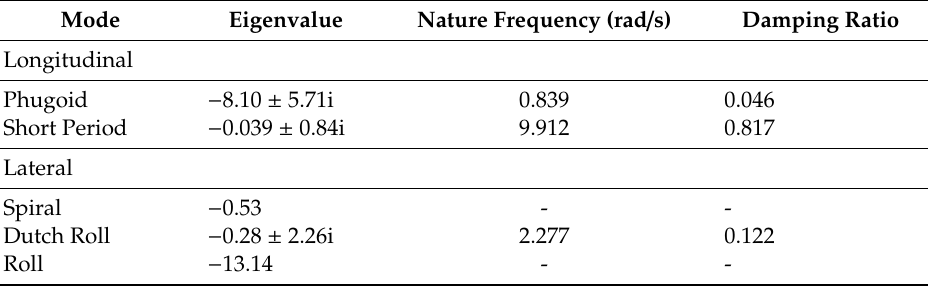
Table 5. Basic flight modes of the longitudinal and lateral system dynamics.